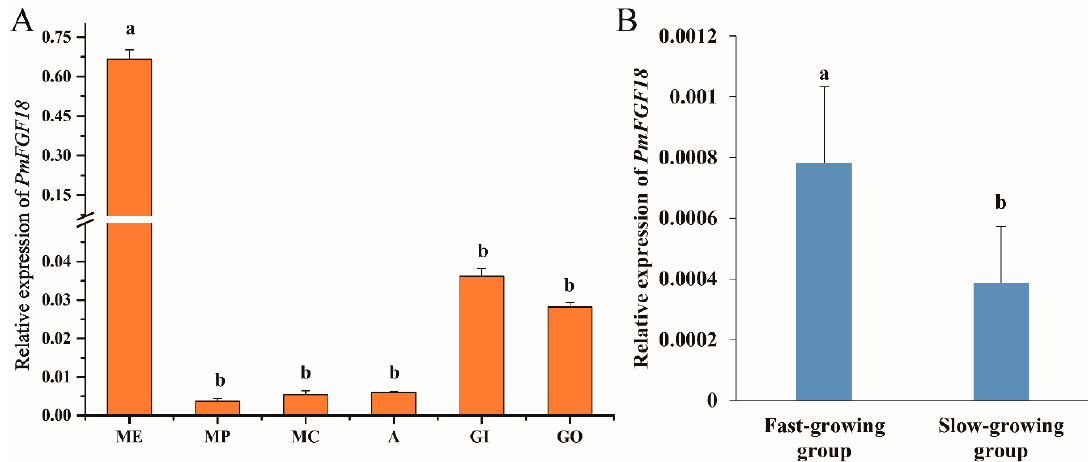
Figure 2. Expression pattern of PmFGF18 from P. f. martensii . ( A ) Expression pattern of PmFGF18 in different tissues. ME: Marginal zone of mantle; MP: Pallial zone of mantle; MC: Central zone of mantle; A: Adductor muscle; GI: Gill; GO: Gonad; Different letters indicate significant differences ( P < 0.05) determined through one-way ANOVA, and the bar represents the standard deviation. ( B ) Expression pattern of PmFGF18 in the fast- and slow-growing groups. Bars with different letters indicate significant differences ( P < 0.05).